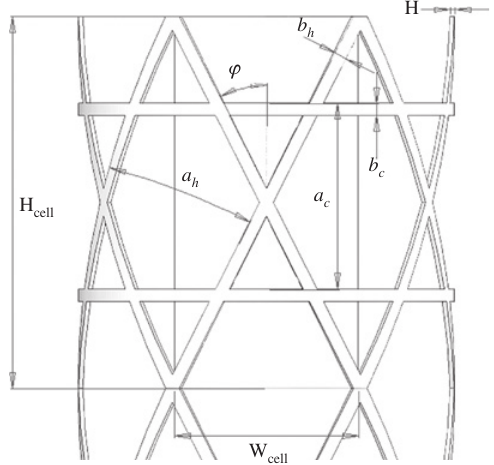
Figure 3 Geometrical variables of a three-ribbed lattice